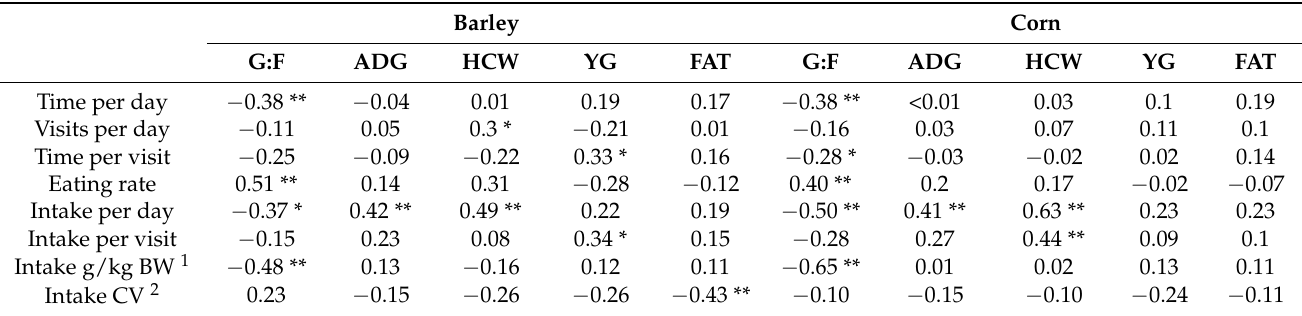
Table 4. Pearson correlation coefficients for pair-wise associations between feeding behavior, performance (gain to feed, G:F; average daily gain, ADG) and carcass characteristics (hot carcass weight, HCW; yield grade, YG) of steers consuming finishing diets containing corn or Hockett barley as basal grains at the Northern Agricultural Research Center. Barley